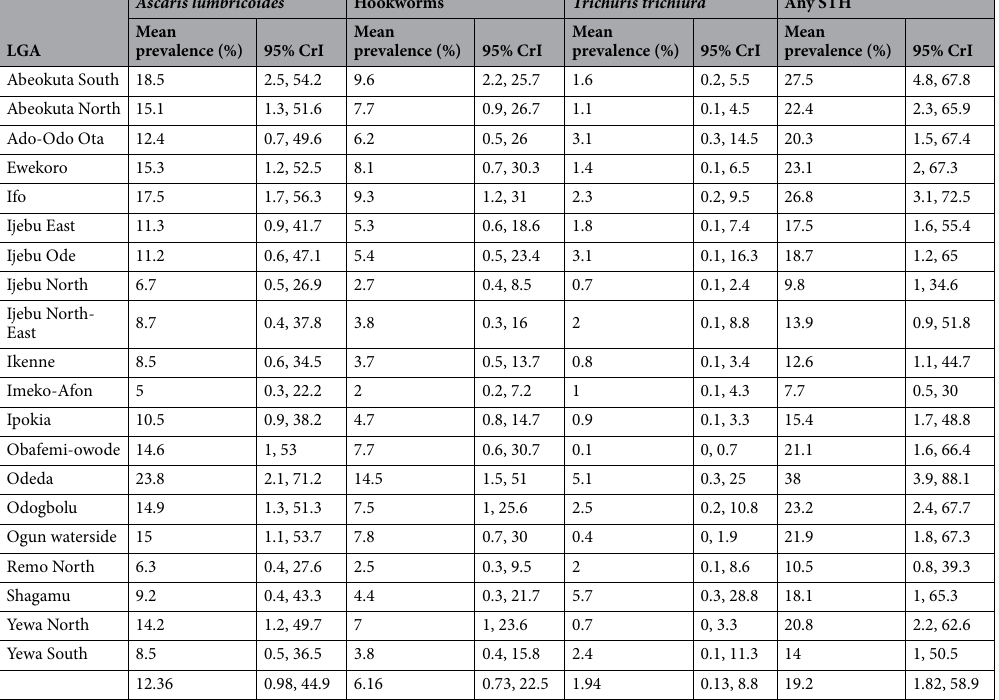
Table 4. Soil-transmitted helminth species-specific model-based predicted prevalence across the 20 LGAs in Ogun State,